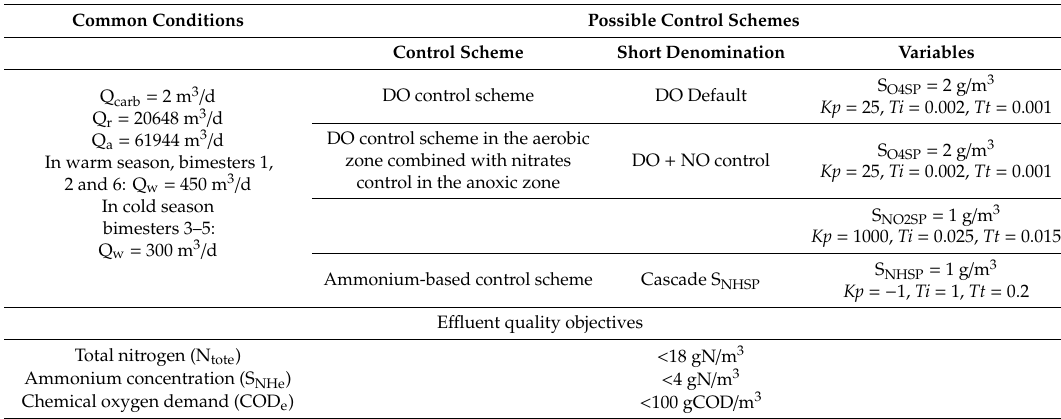
Table 1. BSM2 Default operation strategy with the alternative control